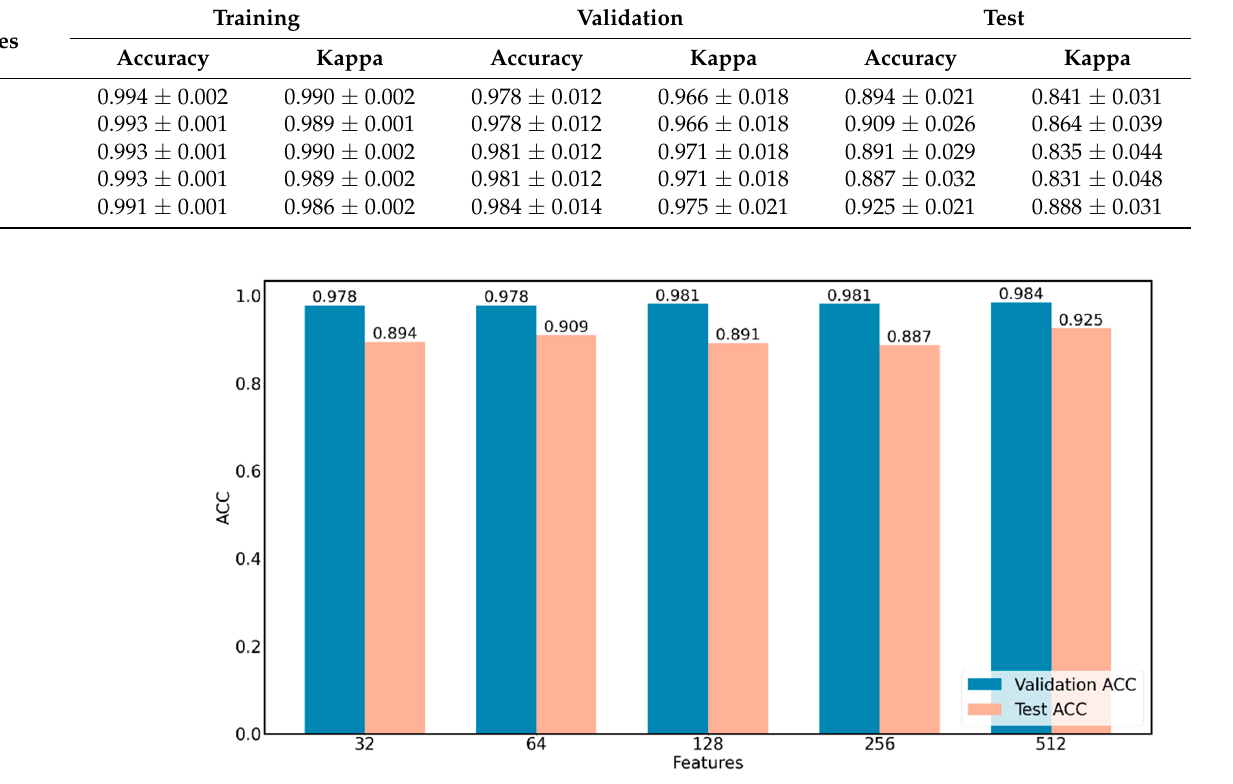
Figure 7. Comparison of Performance of five feature extraction layers of Gerd-VGGNet.